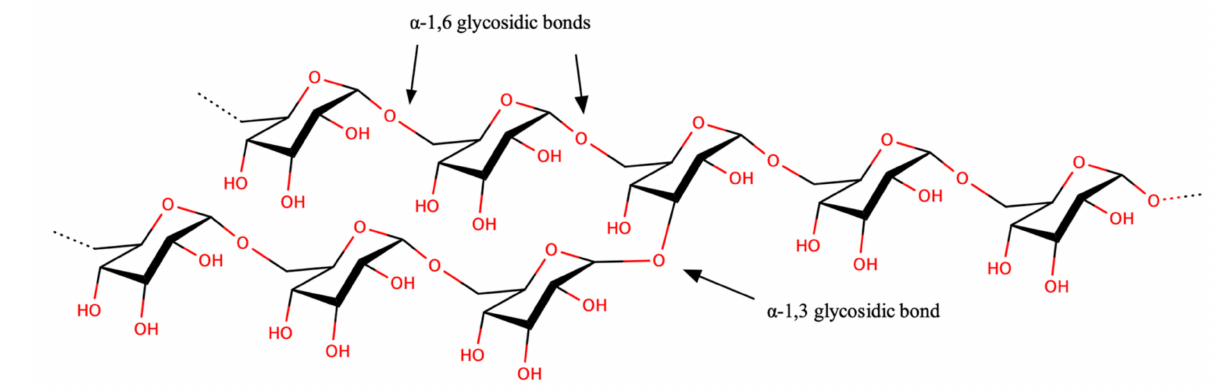
Figure 1. Molecular structure of